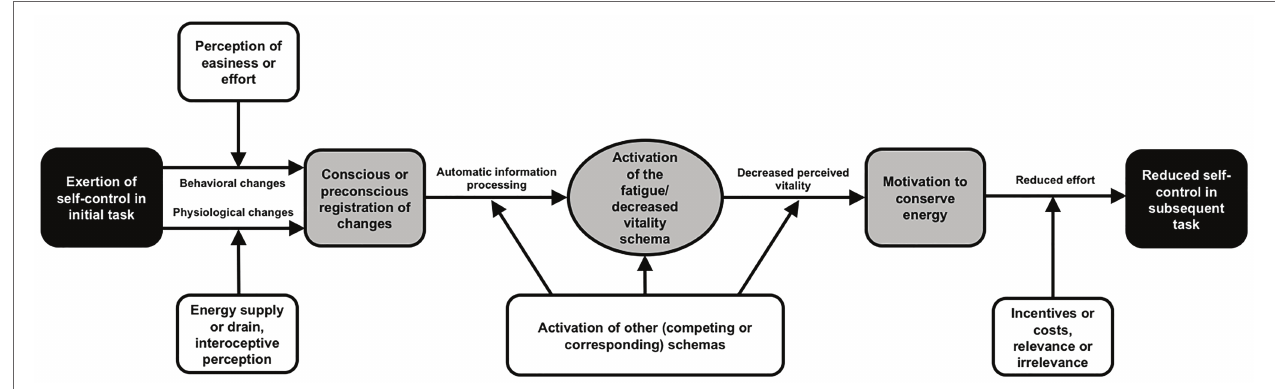
FIGURE 1 | The schema model of self-control (Figure taken from Bertrams, 2020). Black boxes: the observable behavior in self-control studies. Gray boxes and horizontal arrows: the mediating processes within the individual. White boxes: moderating